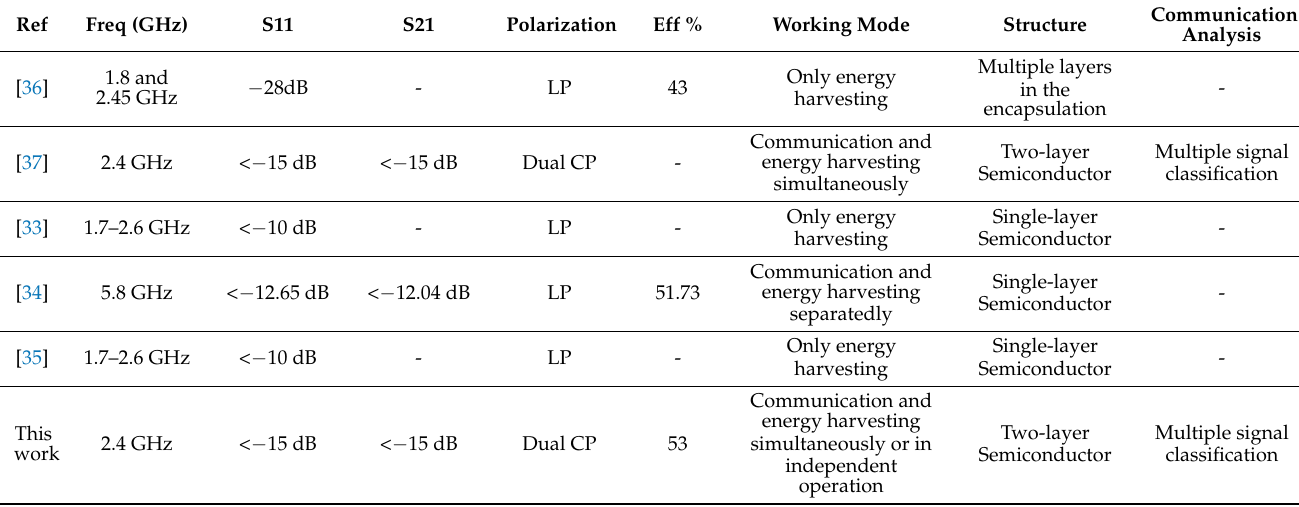
Table 1. Comparison of the CP Antenna with the 2 × 4 Hybrid Couple with Energy Harvesting and wireless sensing with previous